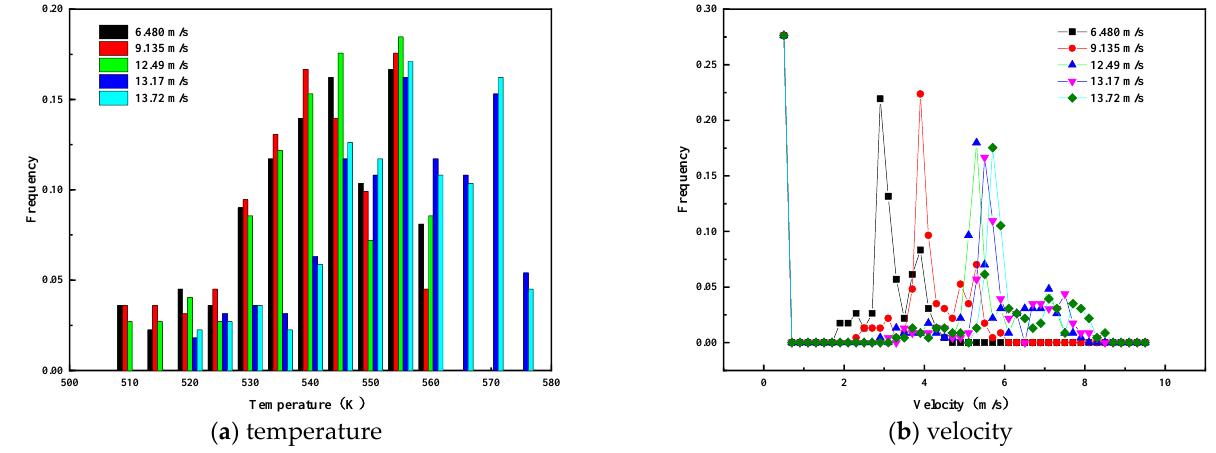
Figure 3. Frequency distribution of temperature and velocity upstream from the first-layer catalyst: (a) temperature;(b) velocity .